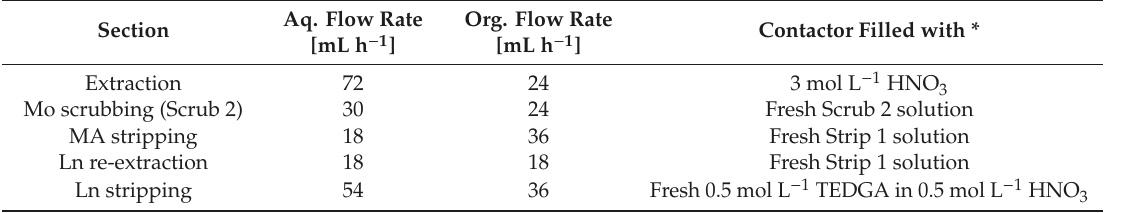
Table 2. Flow rates used in the di ff erent single centrifugal contactor tests and composition of the aqueous phases used to start